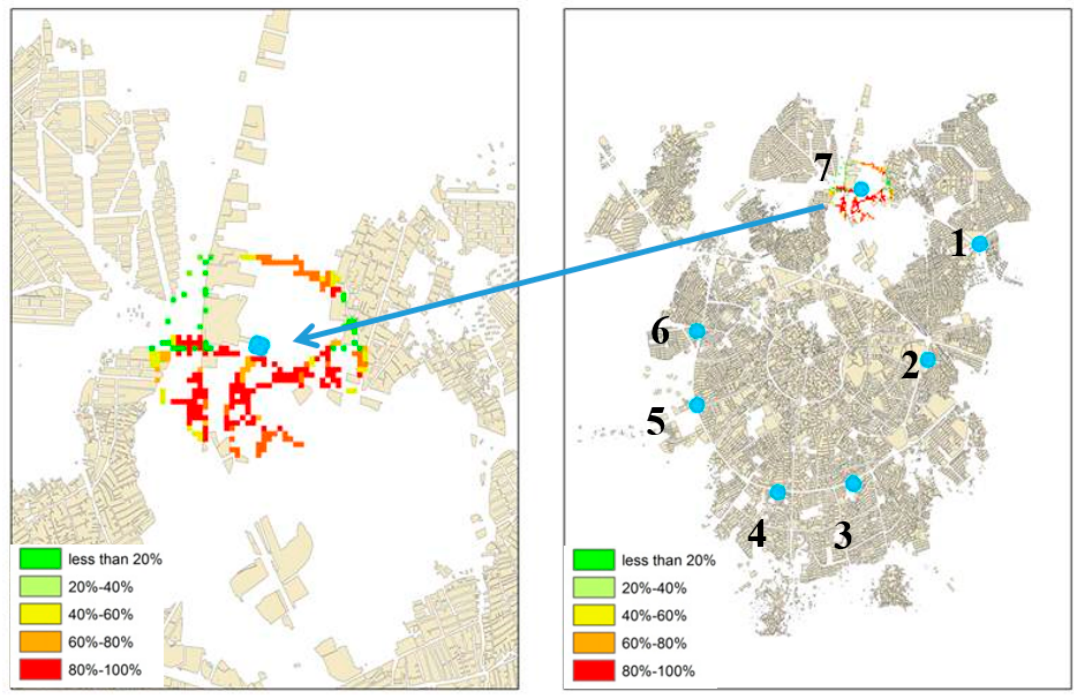
Figure 28. Visibility map of hypothetical tall building No. 7.